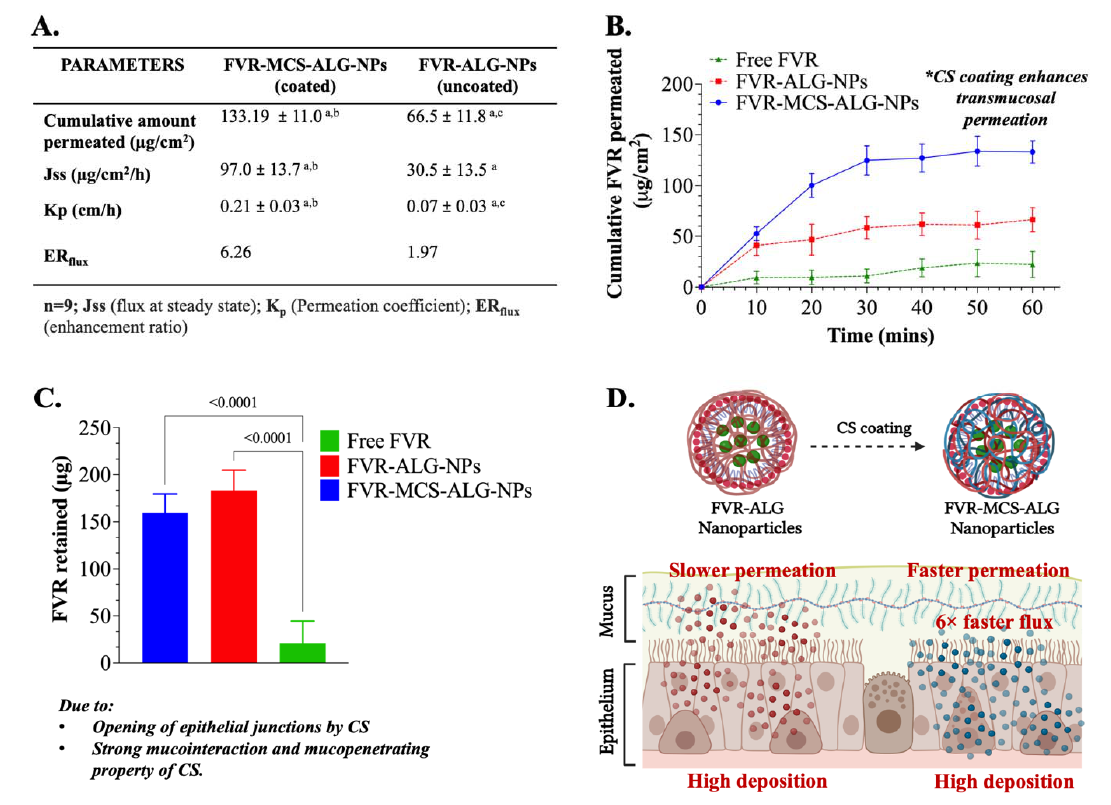
Figure 5. ( A ) Comparison of the permeation profiles of FVR-MCS-ALG-NPs and FVR-ALG-NPs through PNM. The same letter within each row indicates a statistical significance at p < 0.05.; ( B ) permeability study of FVR through PNM; ( C ) approximate amount of FVR deposited in the PNM after 1 h; **** p < 0.0001, ( n = 9); ( D ) illustration of the permeation and deposition properties of the NPs.